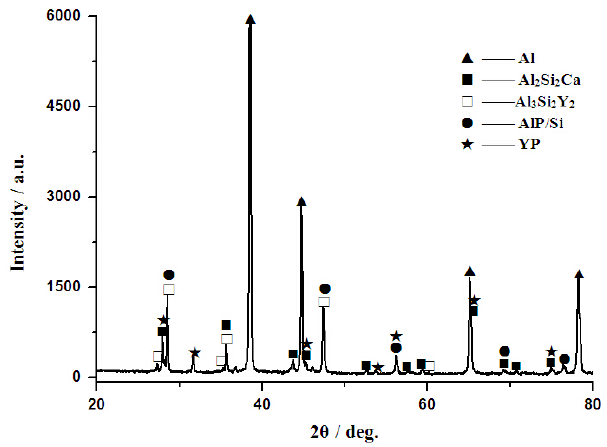
Figure 8. XRD patterns of Al–12Si–2Ca–3Y–1P alloy.